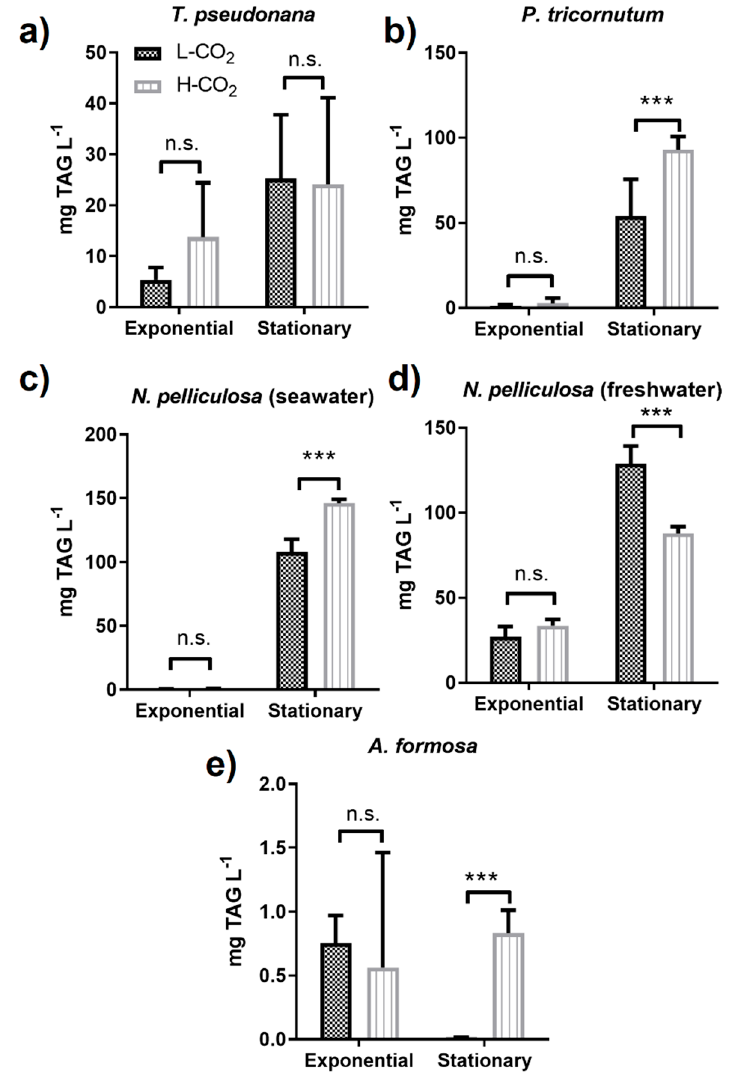
Figure 2. Triacylglycerol (TAG) productivity in diatoms ( a – e ) grown at different CO 2 concentrations. All panels represent low CO 2 (L-CO 2 ; 400 ppm, dark grey bars) and high CO 2 (H-CO 2 ; 20,000 ppm, light grey and dashed bars) as in panel ( a ). Average and error bars (SD) are represented ( n = 3). *** p ≤ 0.005.